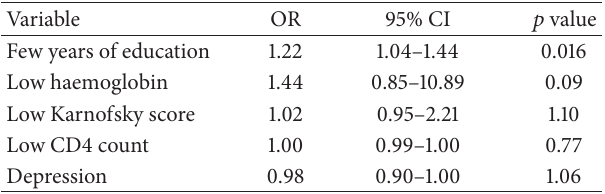
Table 4: Multivariate logistic regression model to determine inde- pendent predictors of symptomatic HAND among HIV-positive